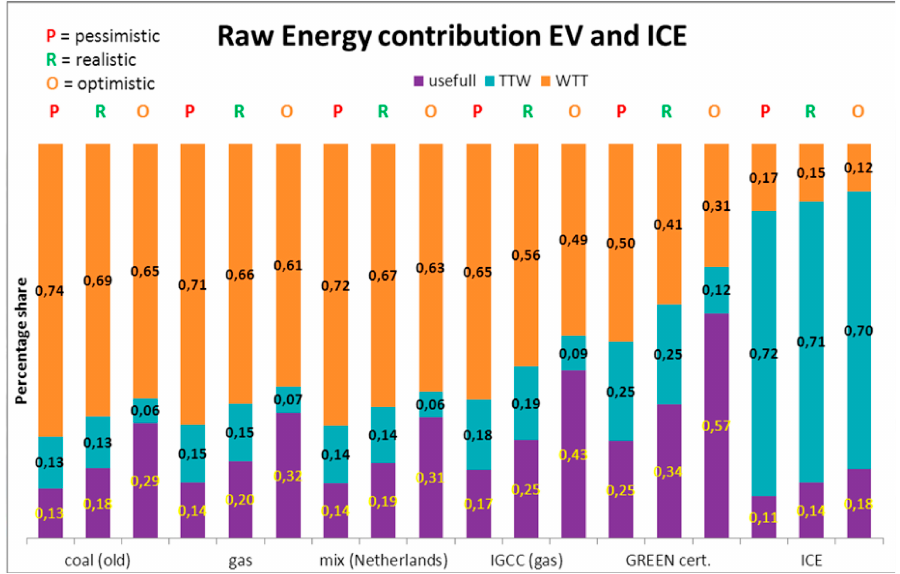
Figure 10. Well-to-wheel comparison EV and ICE (please note: 100% = 1.00 in graph). Reproduced with permission from [12].